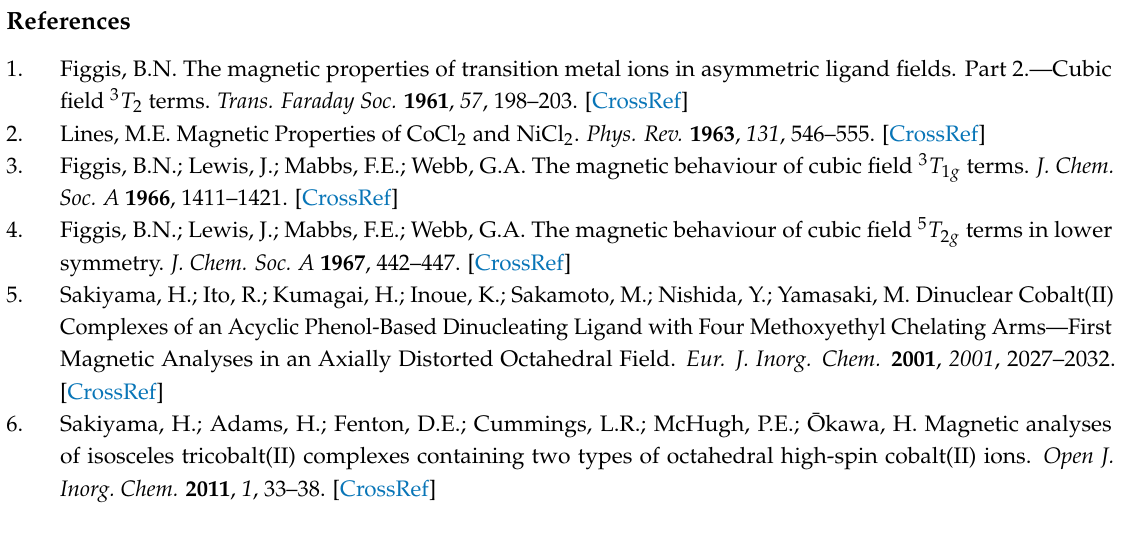
Figgis, B.N. The magnetic properties of transition metal ions in asymmetric ligand fields. Part